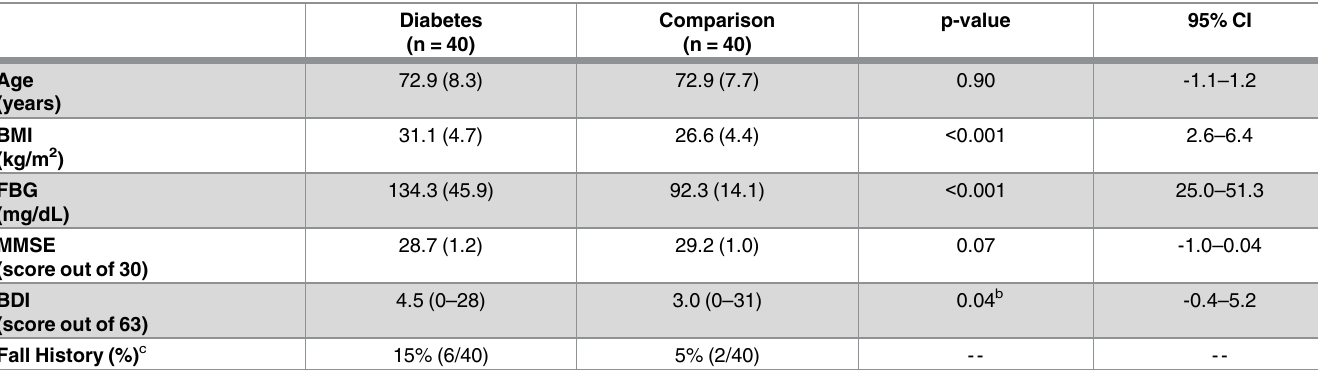
Table 1. Sample characteristics a